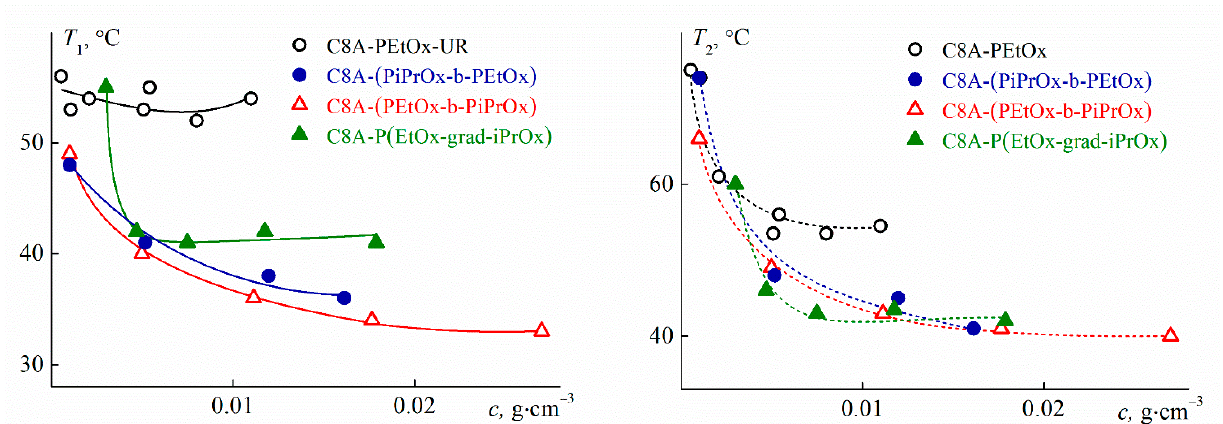
Figure 11. Phase transition temperatures vs. polymer concentration for investigated polymer solutions .